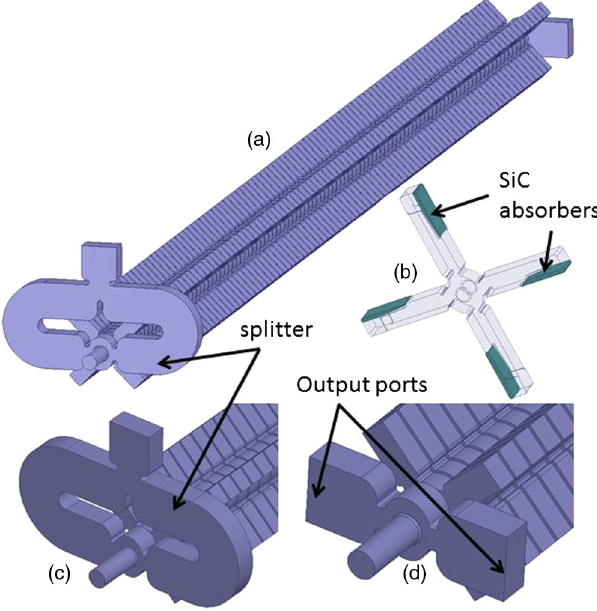
FIG. 1. Sketch of the C -band cavity: (a) whole structure; (b) accelerating cell detail with highlighted SiC absorbers; (c) racetrack input coupler with integrated splitter; (d) racetrack output coupler.